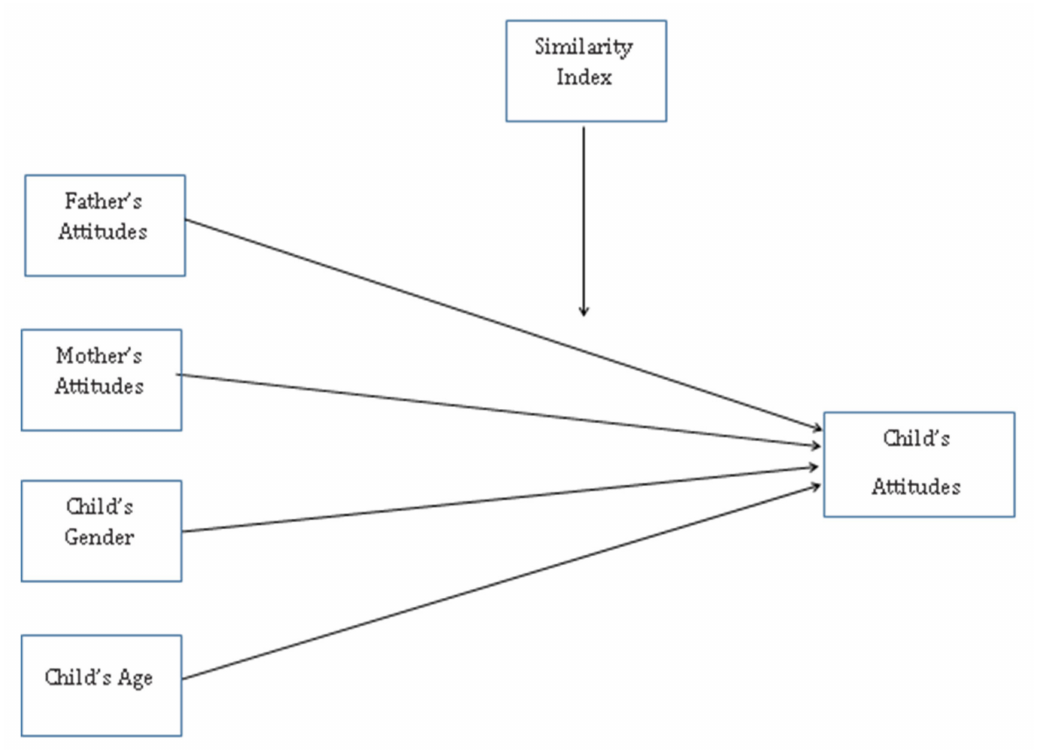
Figure 1. Predicted Model.